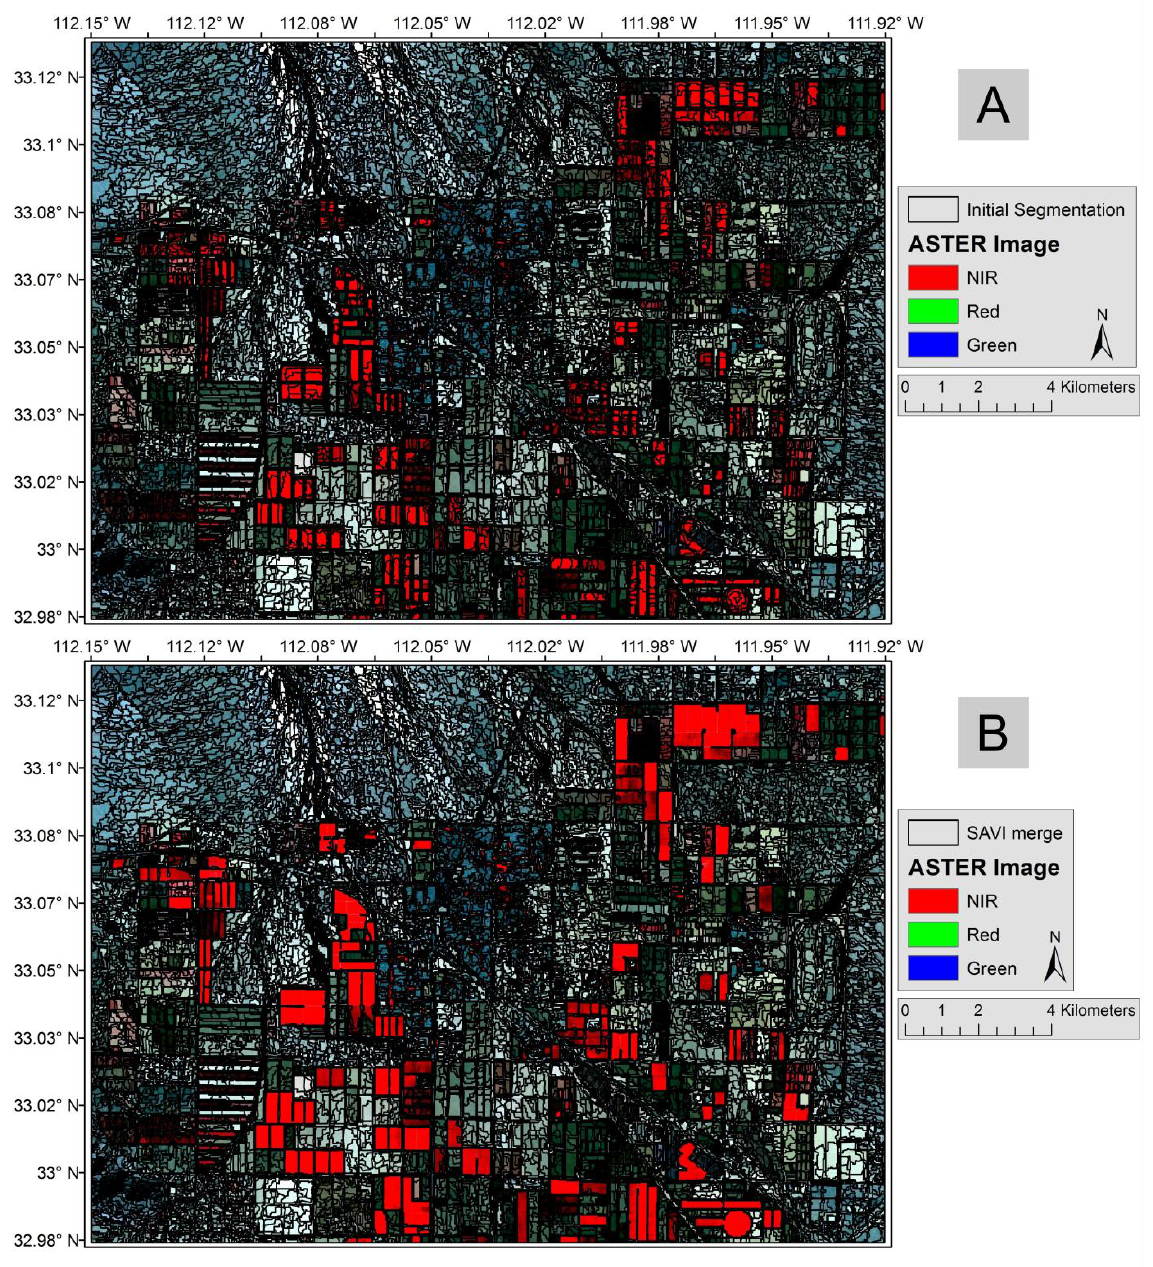
Figure 2. ( A ) Image segmentation using scale parameter of 10. ( B ) New objects after merging those objects with SAVI >